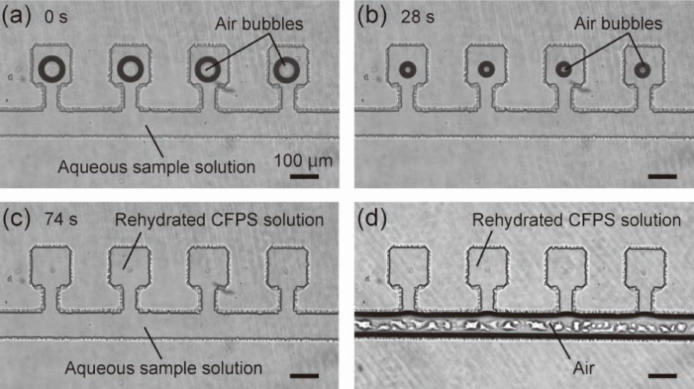
Figure 2. Rehydration of freeze-dried CFPS system in microchambers using an aqueous sample solution. ( a – c ) Microscopic time-lapse images of the microchambers after injecting 1 µ L of the aqueous sample solution from the inlet. ( d ) Microscopic images of the microchambers filled with the rehydrated CFPS solution. The freeze-drying condition was ~10 mTorr, − 20 ◦ C, 3